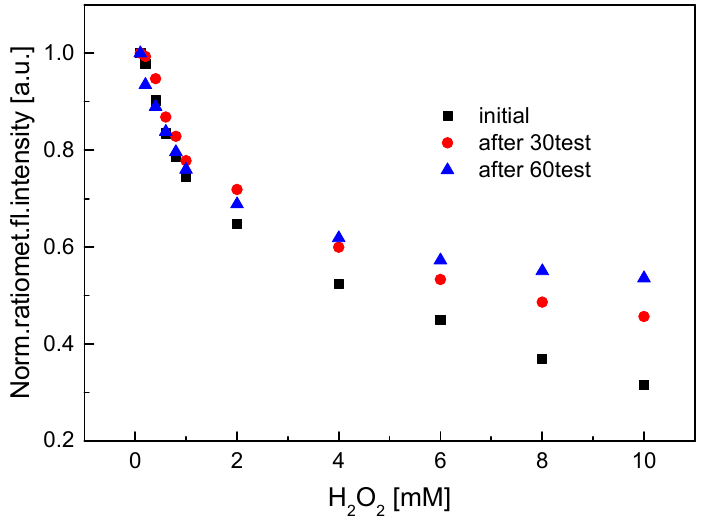
Figure 10. Lifetime of the HRP–QD–AF membrane.